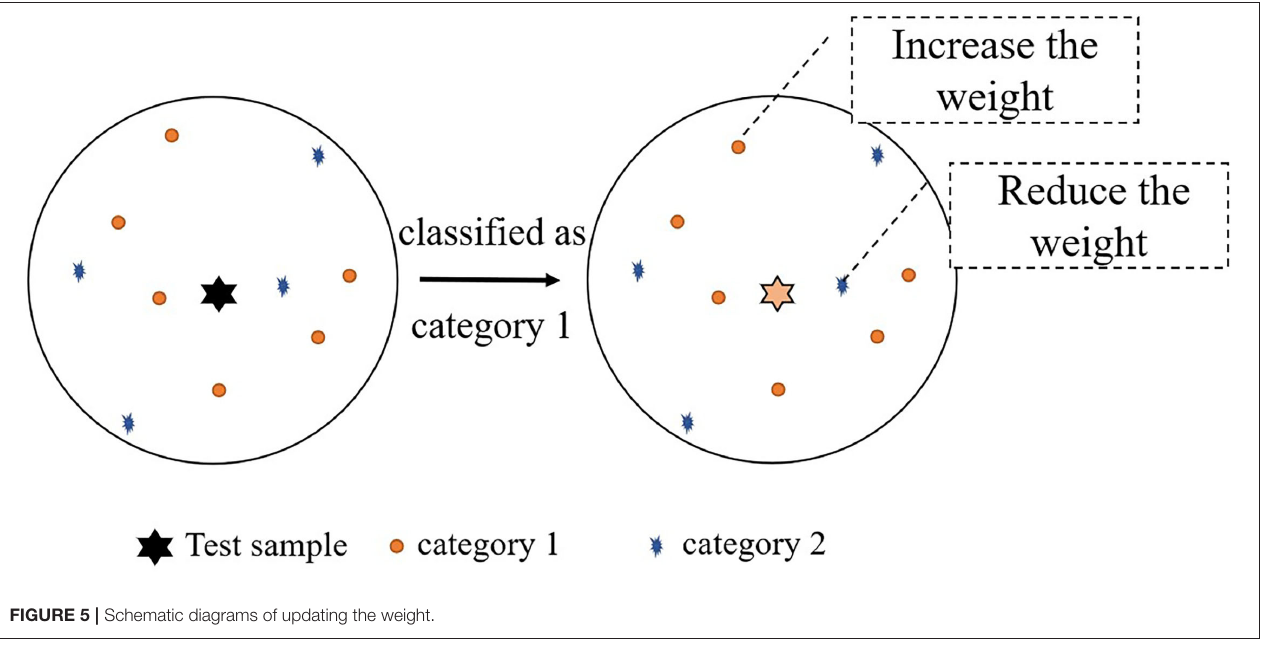
FIGURE 5 | Schematic diagrams of updating the weight.